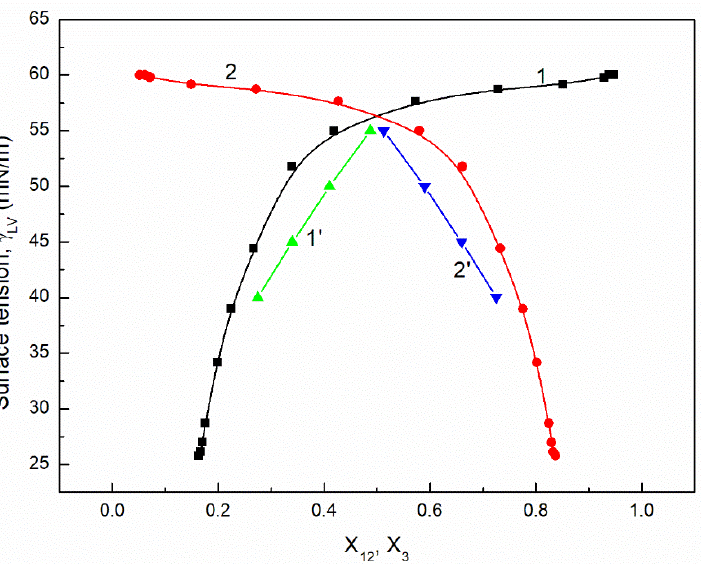
Figure 9. A plot of the surface tension ( γ LV ) of the aqueous solutions of CTAB + TX100 + FC1 mixture at the constant concentration of the binary mixture CTAB + TX100 ( C 12 ) and γ LV = 60 mN/m (m1 (60) vs. the composition of the ternary mixture in the monolayer ( X 12 and X 3 ) determined based on the contribution of the particular surfactant in the mixture to the reduction of the water surface tension (curves 1 and 2) and calculated from Equation (5) (curves 1’ and 2’). X 12 corresponds to the sum of the CTAB ( X 1 ) and TX100 ( X 2 ) fractions and X 3 corresponds to the FC1